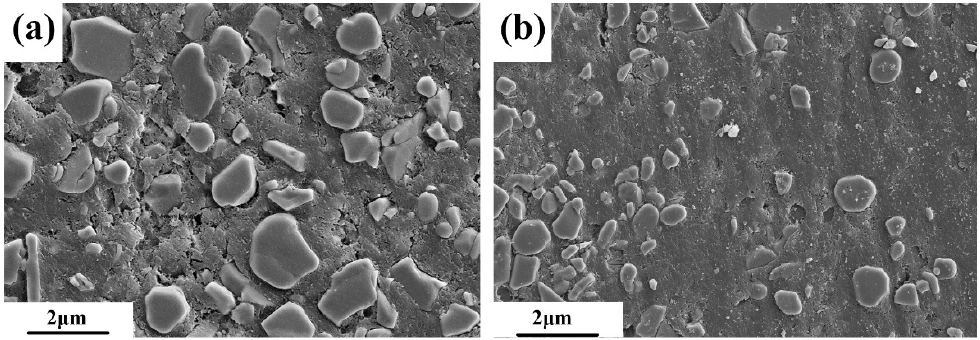
Figure 2. Scanning Electron Microscope (SEM) images of alumina ( a ) and bauxite ( b ). Table 1. The chemical composition of the raw materials.